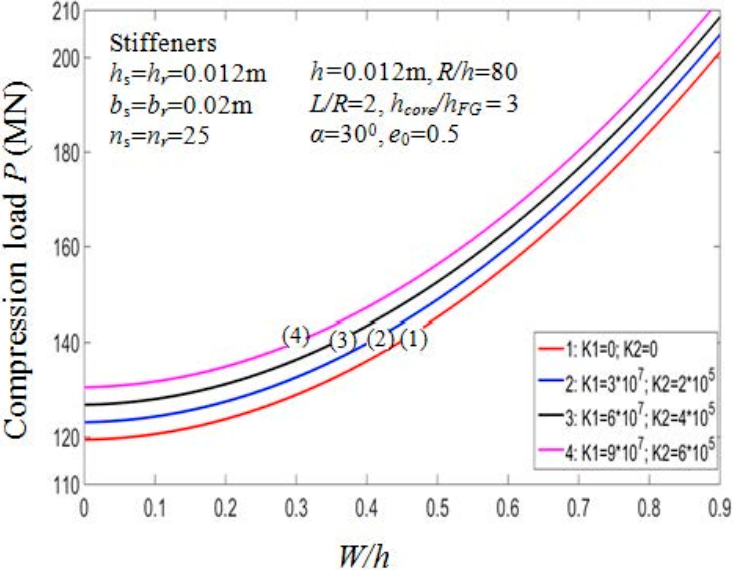
Figure 13. Effects of foundation on postbuckling load—deflection curves (Case 1, k 2 = k 3 = k = 1).